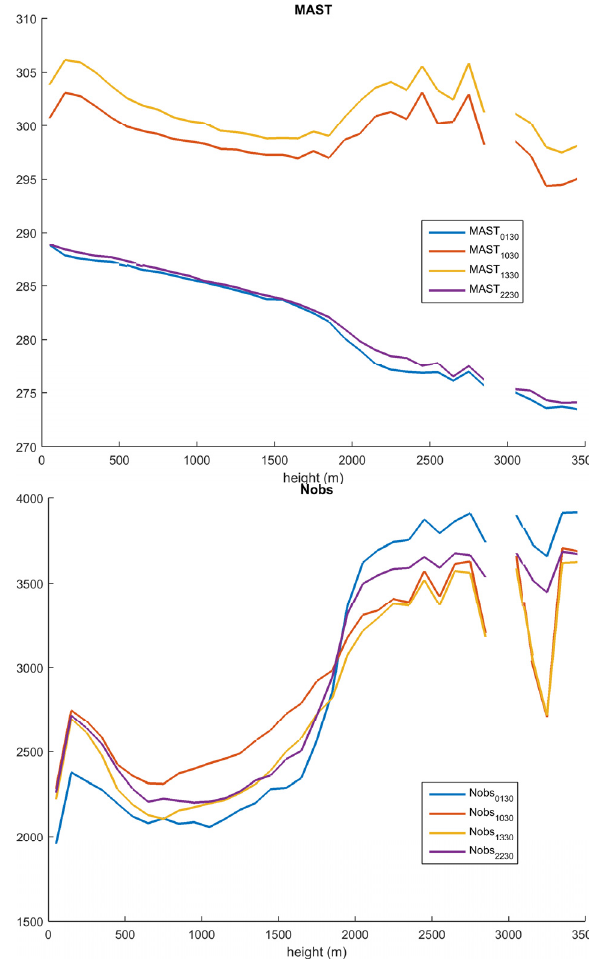
Figure 9. Distributions of mean annual surface temperature and yearly amplitude of surface temperature in K and number of observations at 1:30 by height in km.